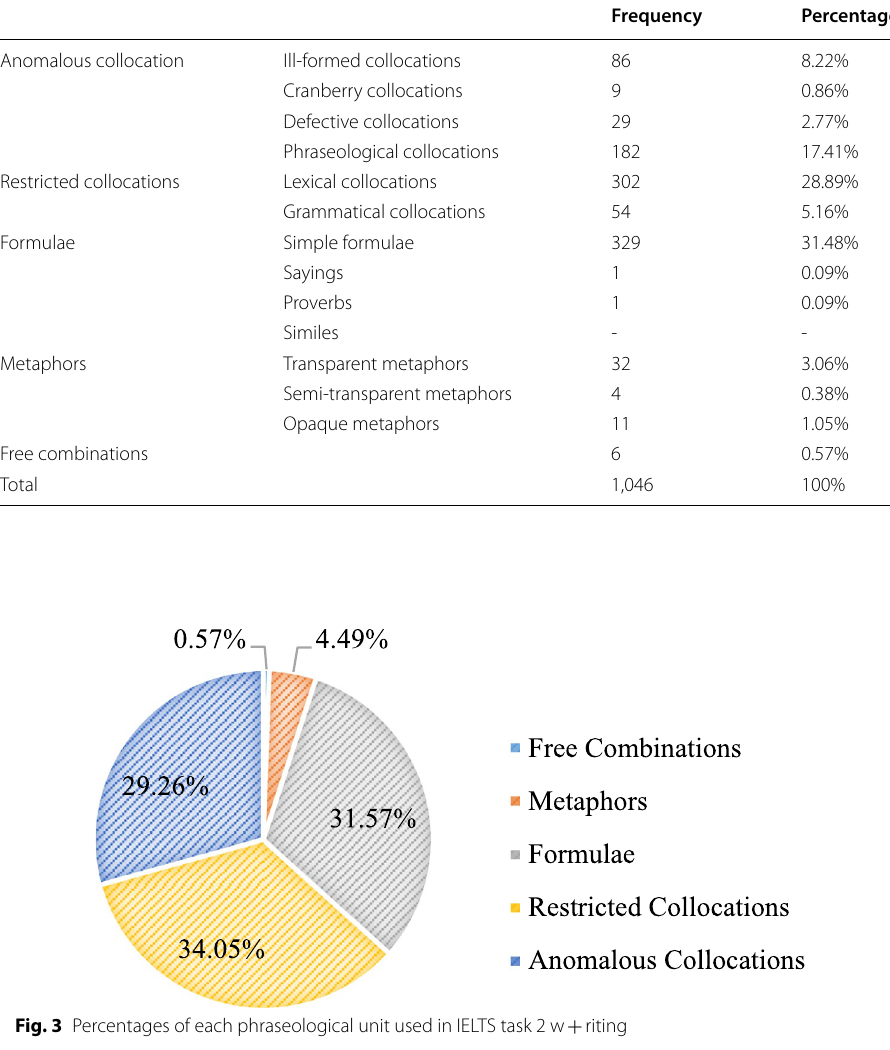
Table 7 Overall phraseological units extracted from IELTS task 2 writing essays